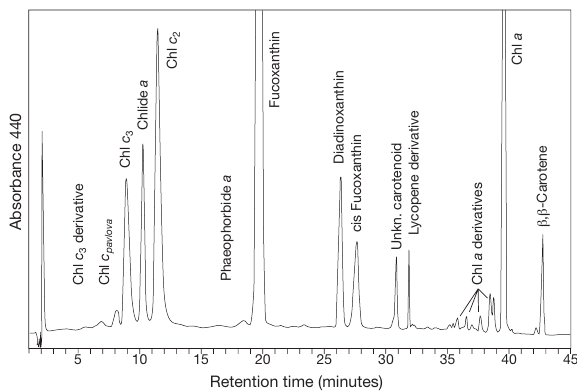
Fig . 4. – representative absorbance chromatogram obtained for an extract of Pseudo-nitzschia multistriata culture, simultaneously containing most pigments and degradation products detected in the culture collection employed.